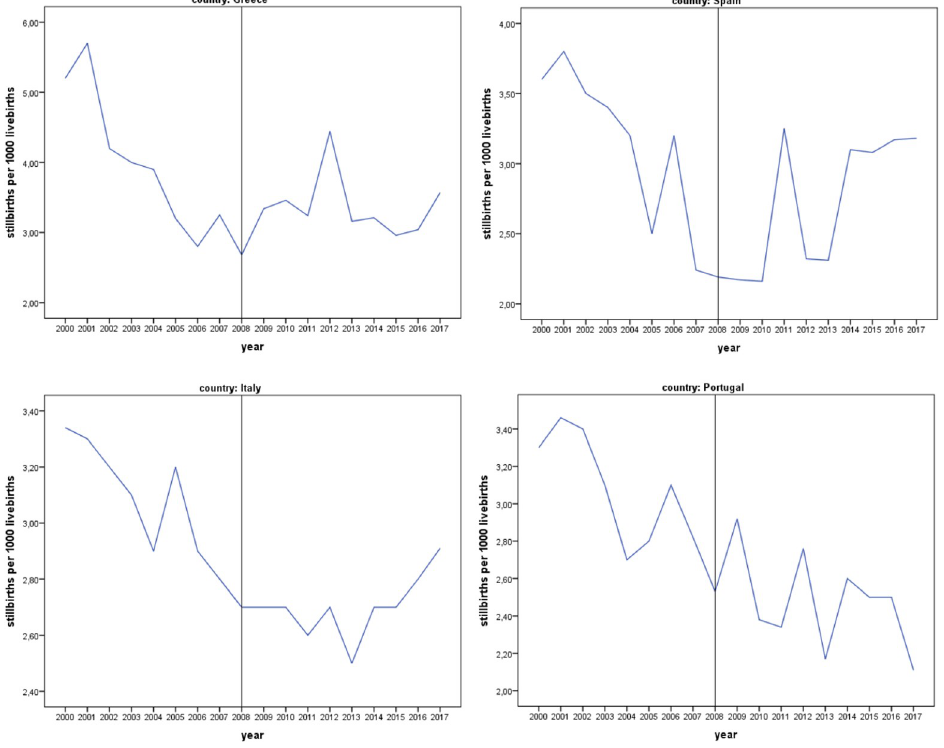
Fig 1. Trends in stillbirth ratios by country: